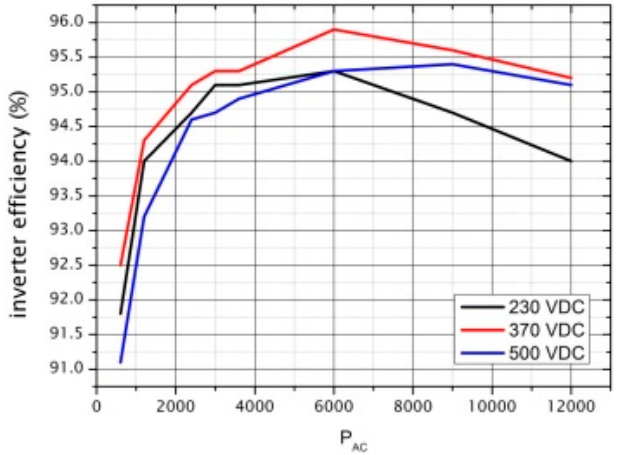
Figure A1. Efficiency curve of inverter with the AC Power for different DC voltages.